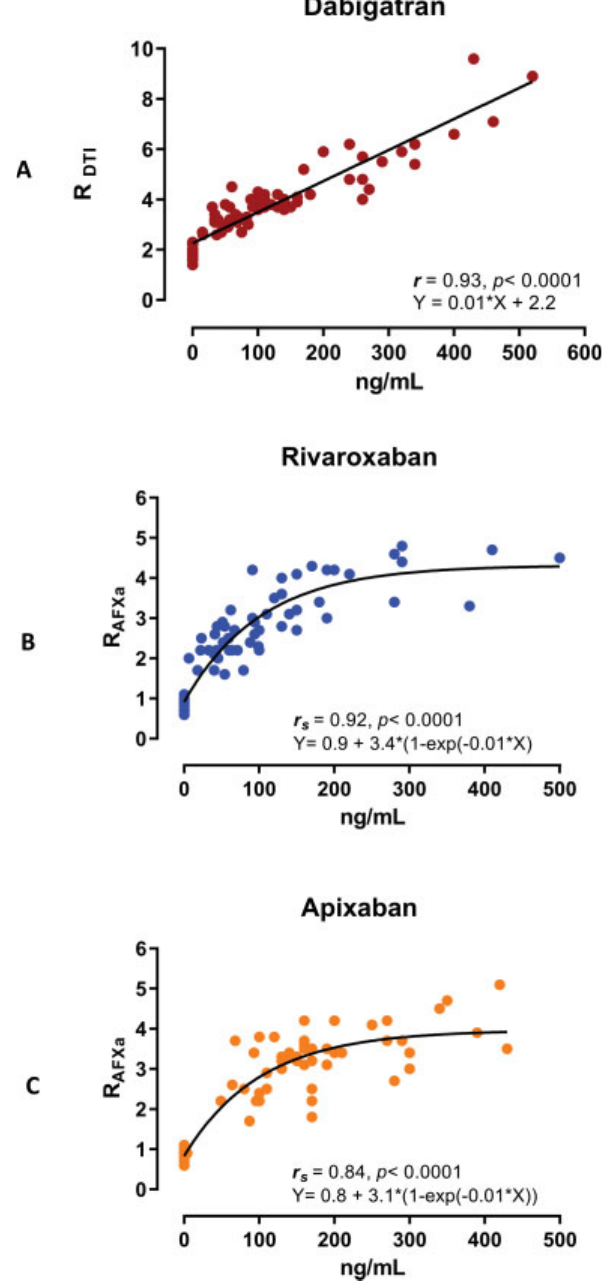
Fig. 1 ( A – C ) The scatter diagram of DOAC concentrations against R- time. R DTI indicates using the DTI channel; R FXa indicates using the AFXa channel. AFXa, antifactor-Xa; DOAC, direct-acting oral anticoagulants; DTI, direct thrombin inhibitor; R, reaction